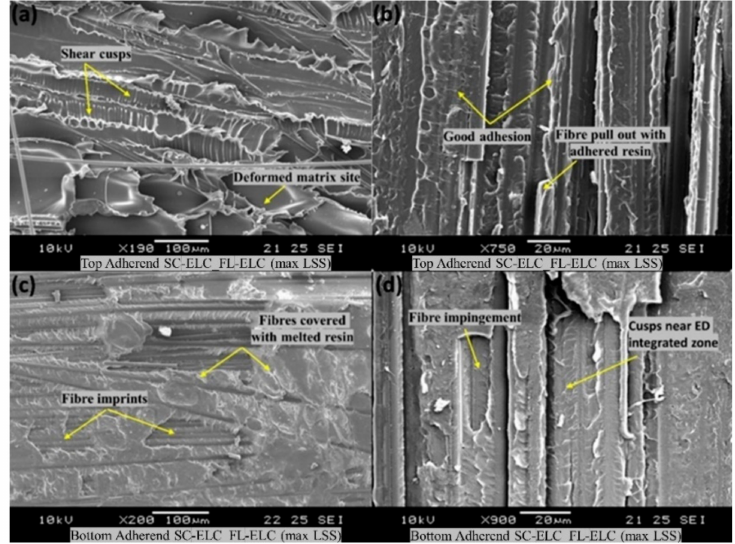
Figure 16. Scanning Electron Microscope (SEM) fractography of SC-ELC_FL-ELC at maximum